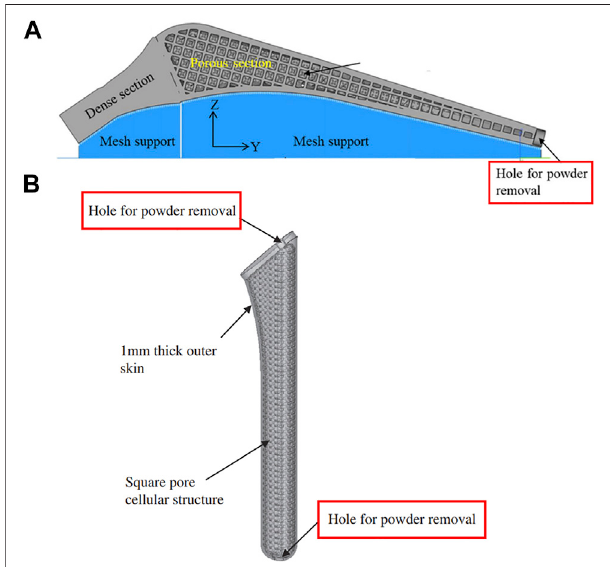
FIGURE 7 | (A) Hole positioned at the bottom of the femoral stem for powder removal designed by Mehboob et al. (2020b); (B) Powder removal holes at the top and bottom of the femoral stem designed by Hazlehurst et al. (2014a).